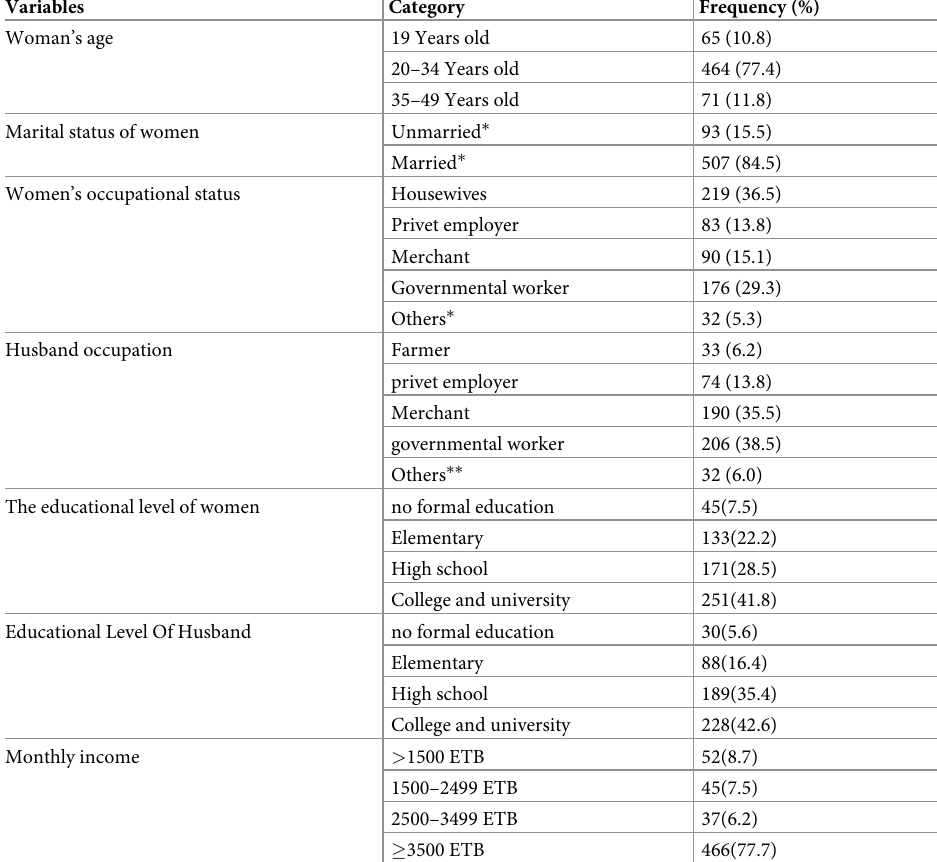
Table 2. Socio-demographic characteristics of pregnant women attending ANC in Hawassa city Health facility, Sidama Regional State, Ethiopia,